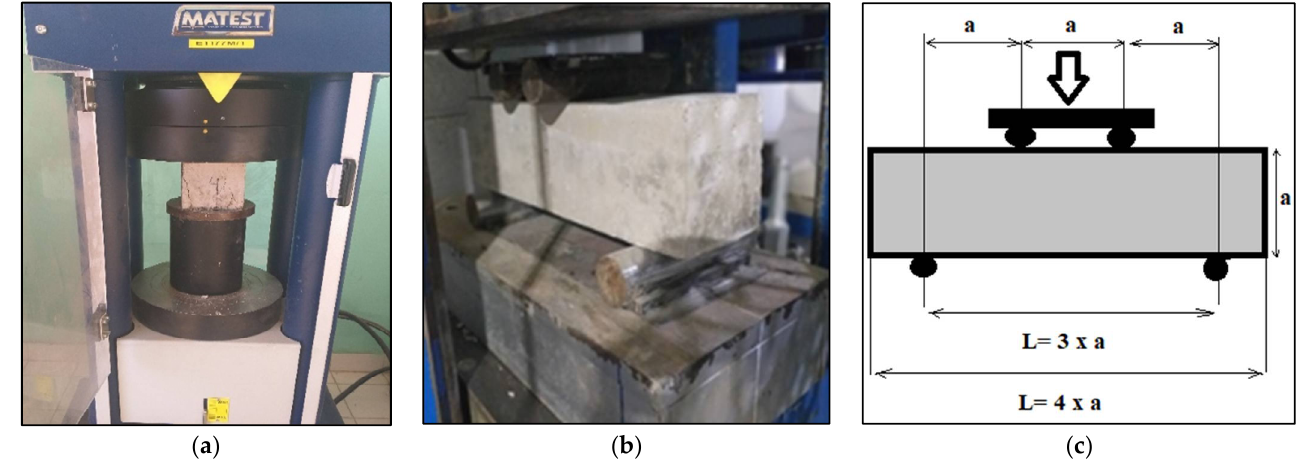
Figure 6. Mechanical tests: ( a ) compressive strength, ( b , c ) flexural